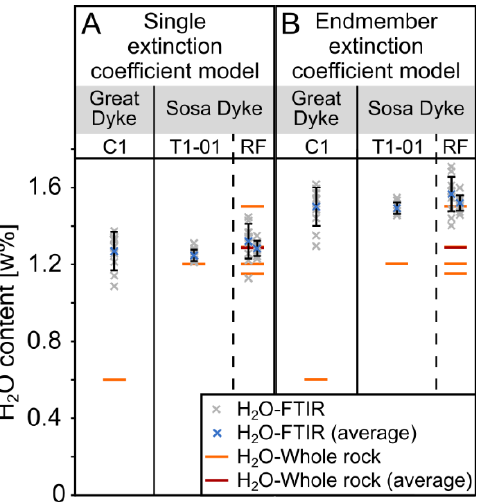
Figure A2. Water content FTIR and whole rock geochemistry. ( A ) Single H 2 O extinction coefficient model εH 2 O 3550 averaged values from [61]; ( B ) FTIR H 2 O endmember extinction coefficient ( ε ) model using differentiated εH 2 O 3550 and εOH 3550 values from [62,63]; Whole rock geochemistry values are the same in both cases see Tables A1 and A2. The black error bars are marking the standard deviation determined from the 10 different measurements. RF—Reference samples to test repeatability of the FTIR measurements.